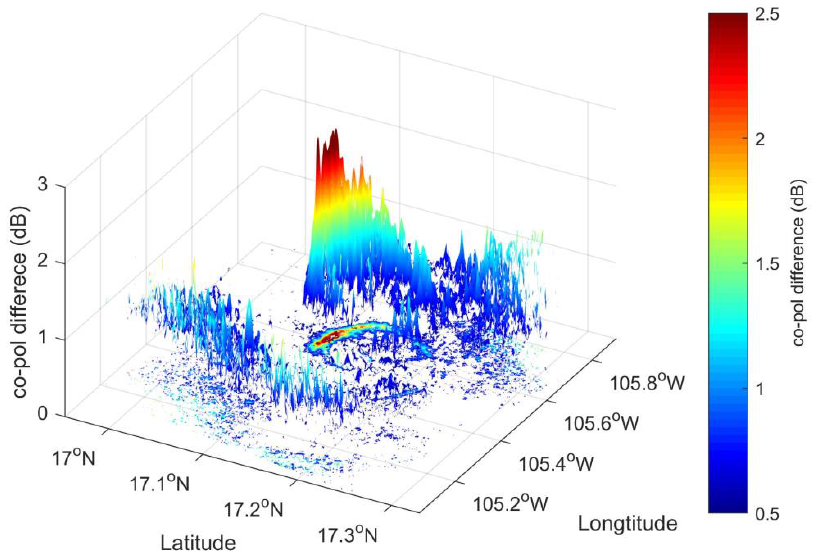
Figure 6. The rain index for Hurricane Patricia (2015) as derived from the proposed quality index based on the difference of co-pol NRCSs between SAR observations and model simulation.